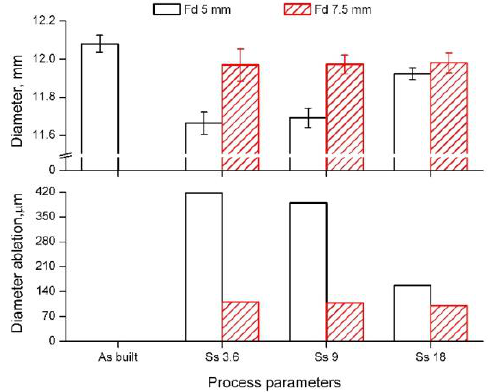
Figure 9. Samples diameter and diameter ablation vs. laser parameters.